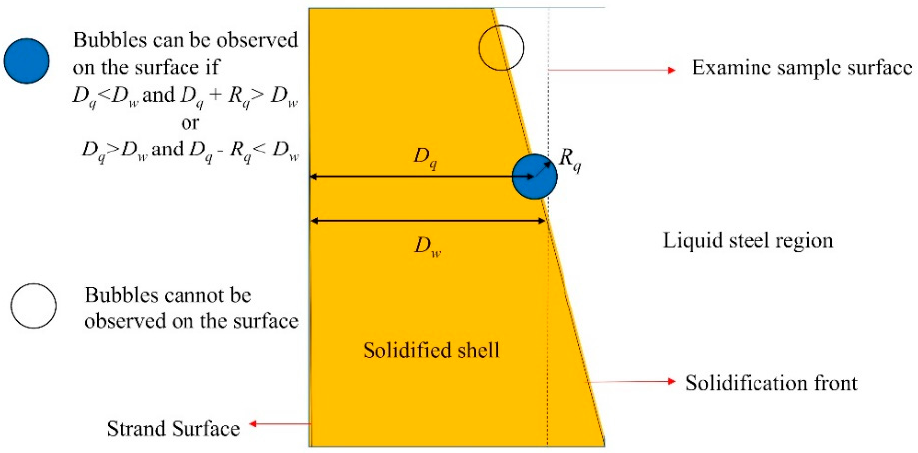
Figure 1. Schematic of the model features for the bubble capture description.